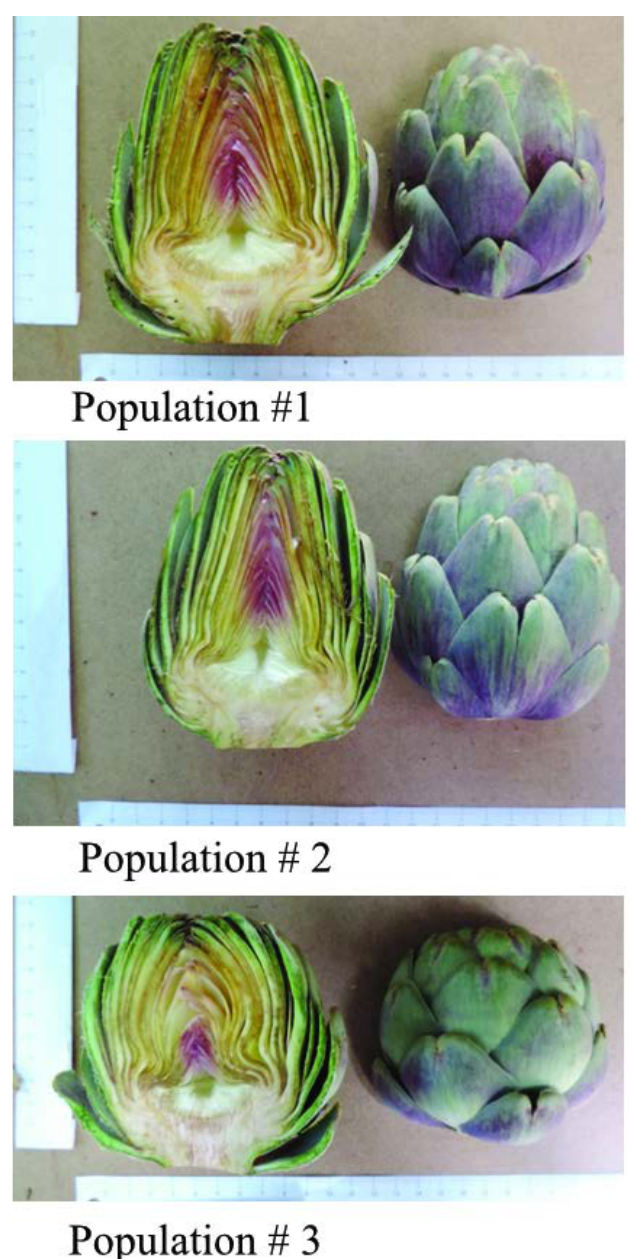
Figure 3. The three populations of ‘Carciofo di Lucera’ considered for their morphological characterization. Table 1. Morphological descriptors for the three populations according to UPOV and GIBA. The descriptors in red are the ones required for the entry in the conservation varieties catalogue.